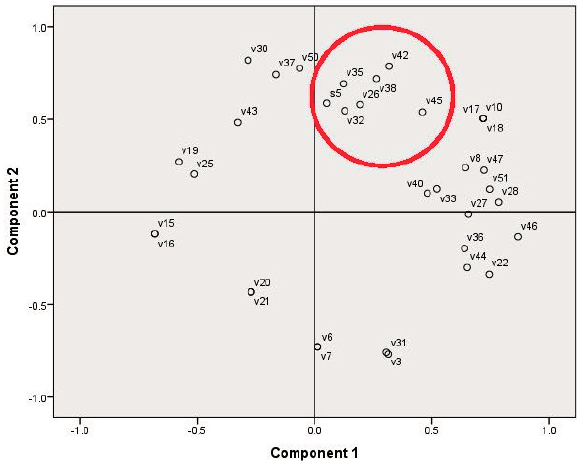
Figure 5. PCA on the cell line proliferation inhibition and concentration of moss secondary metabolites (area marked with red circle: the human breast adenocarcinoma proliferation data (S5) and substance numbers (v1–v53) according to Table 5 were used as